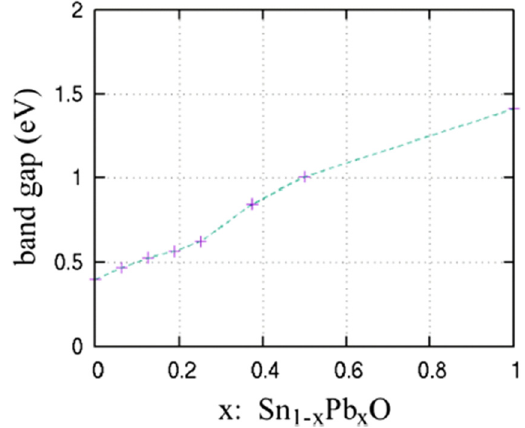
Figure 12: Computed band gap with regards to the Pb content in the compound [ 94 ]